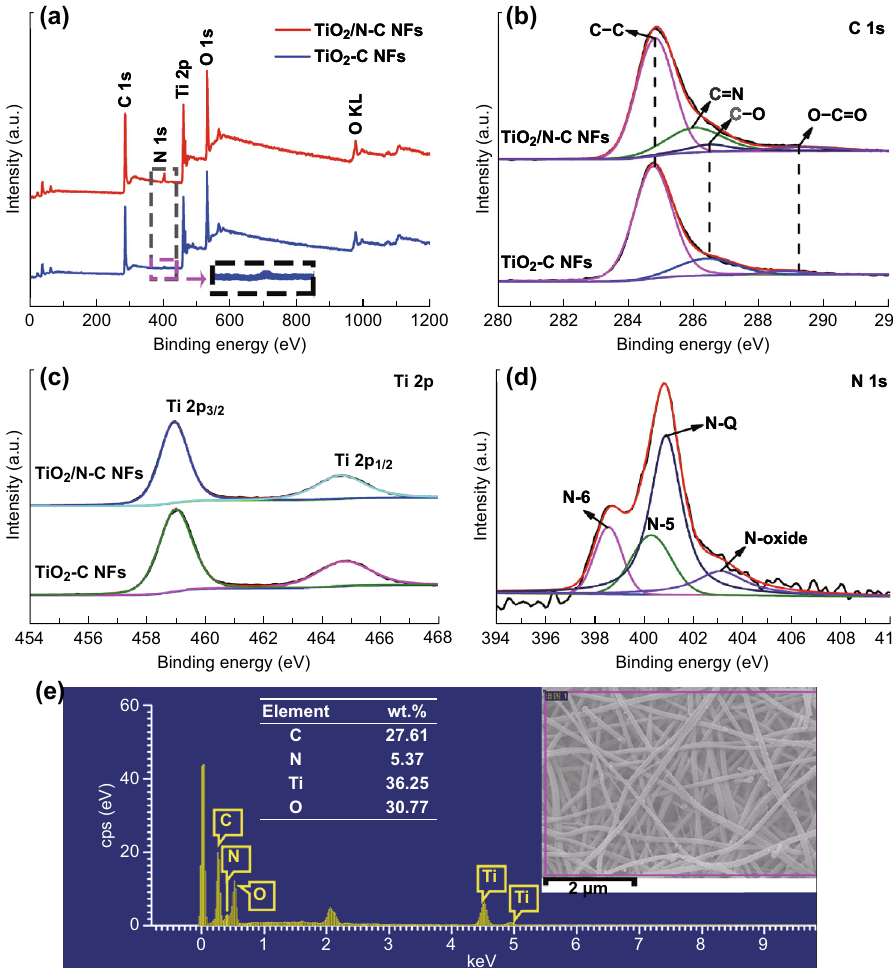
Fig. 5 a XPS wide scan spectra of TiO 2 –C NFs and TiO 2 /N–C NFs. High-resolution b C 1 s and c Ti 2 p XPS spectra of TiO 2 –C NFs and TiO 2 / N–C NFs. d High-resolution N 1 s spectra of TiO 2 /N–C NFs. e EDS spectrum of TiO 2 /N–C